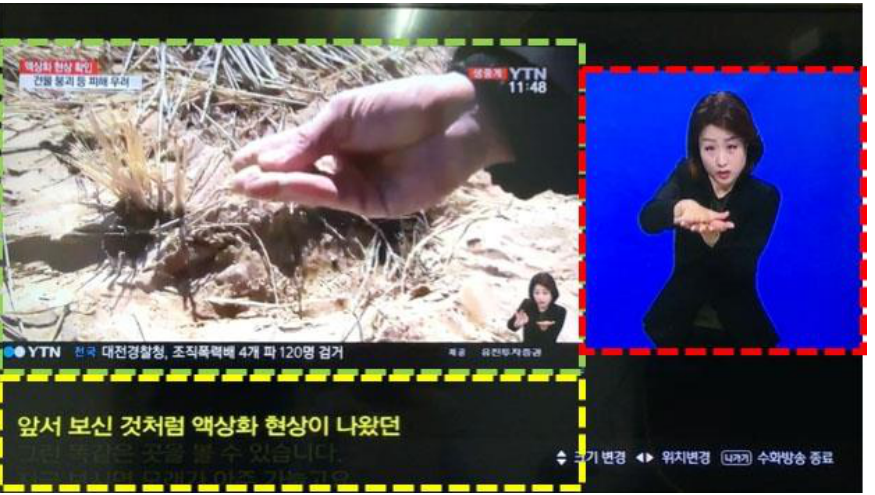
Figure 2. Example of smart Korean sign language broadcasting services. Translation of subtitle – In yellow box: “As you saw earlier, the liquidation phenomenon came out ” .